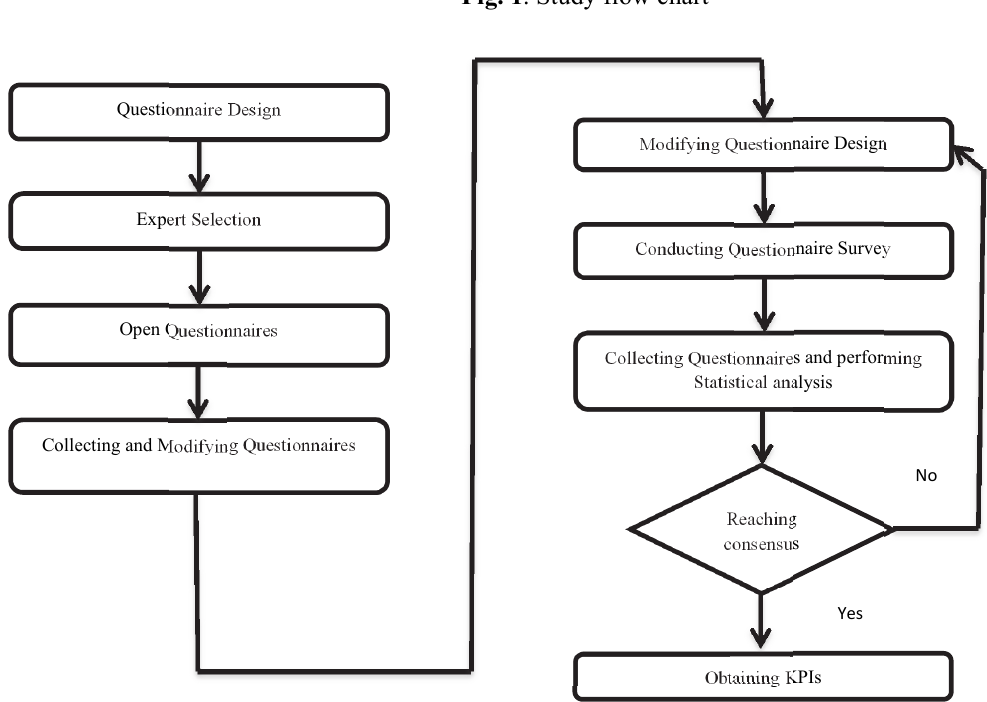
Fig. 2. The Delphi method process (Tsai & Cheng,